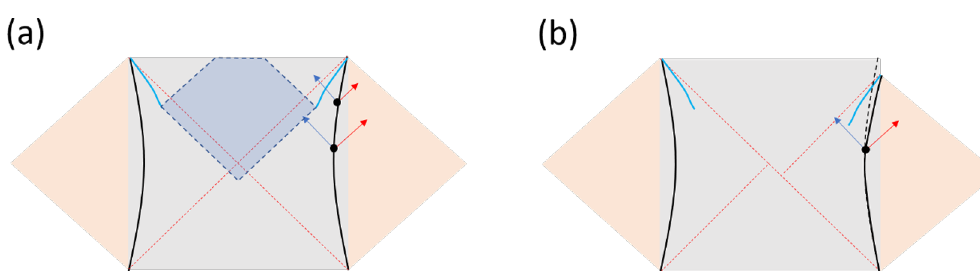
Figure 12. Bulk dual interpretation of the boundary perturbation of adding a (cid:31) i fermion. We sketch the Penrose diagram of an AdS 2 eternal black hole coupled with the (cid:13)at space bath, discussed in ref. [12]. The blue solid curve indicates the worldline of the boundary of the island. (a) When backreaction is neglected, this perturbation creates a superposition of infalling fermion mode (blue arrow) and outgoing fermion mode (red arrow). The blue diamond is contained in the entanglement wedge of the bath at the Page time. A particle created earlier than the Page time can be retrieved from the bath soon after the Page time, while a particle created after Page time can be retrieved after a (cid:12)nite scrambling time. (b) Considering the backreaction, the infalling fermion induces a change of the boundary location, described by the Schwarzian action in low energy. This leads to a decreasing overlap between the perturbed and unperturbed states of the bath even before the Page time (see